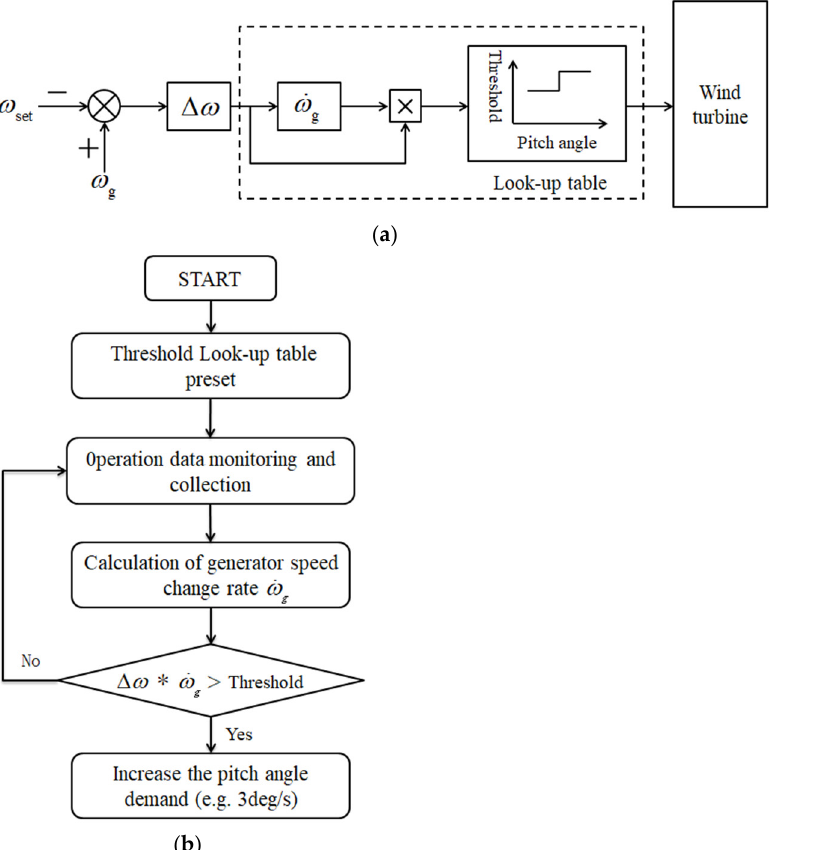
Figure 3. Tower clearance safety protection strategy. ( a ) Revised pitch controller. ( b ) Flow of the strategy.